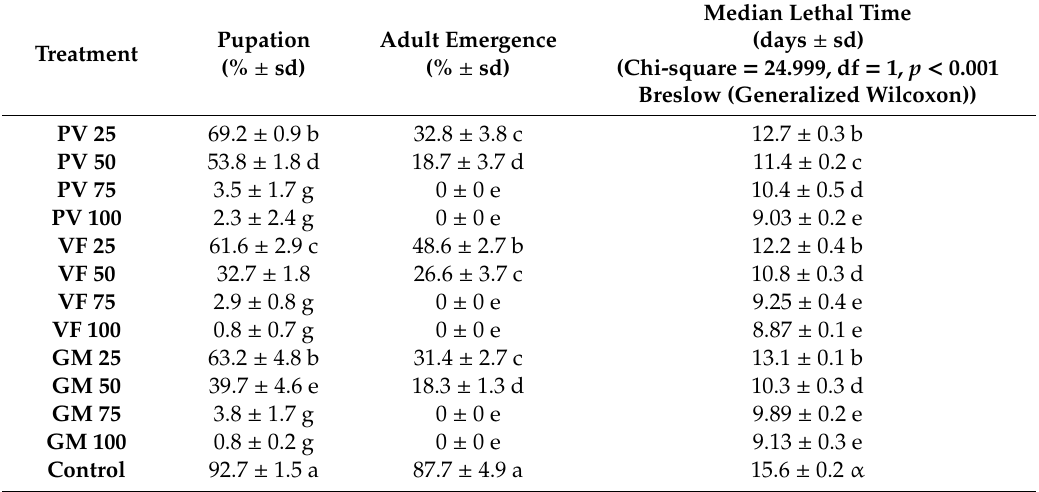
Table 1. Mean e ff ect of P. vulgaris , V. faba and G. max flour on pupation, adult emergence, and median survival time of larval instars of T. granarium . Means sharing the same lower-case letters are not significantly di ff erent from each other.